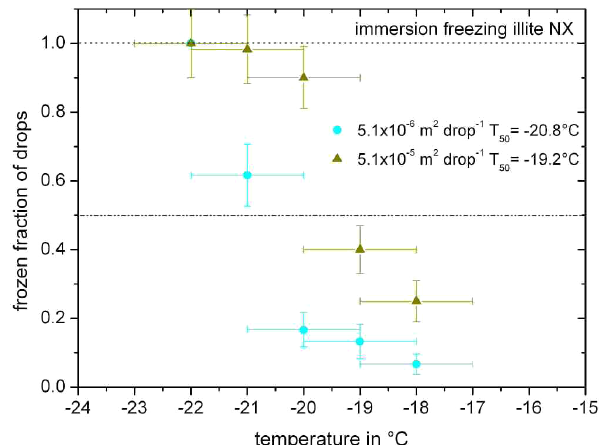
Figure 4. Immersion freezing of illite NX in the wind tunnel: frozen fraction of drops as function of temperature for two different parti- cle surface areas per drop. Accumulated values within total obser- vation time of 30s.